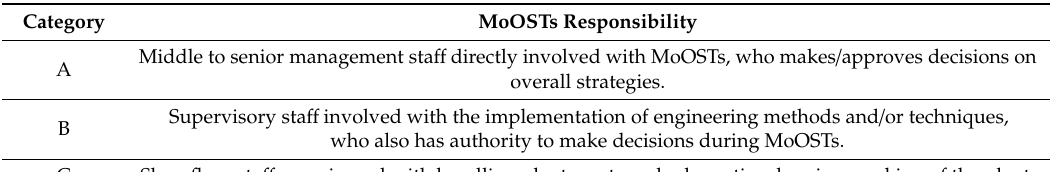
Table 5. Group decision panel.